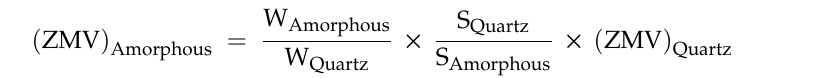
Figure 4. Measured TGA of all specimens .